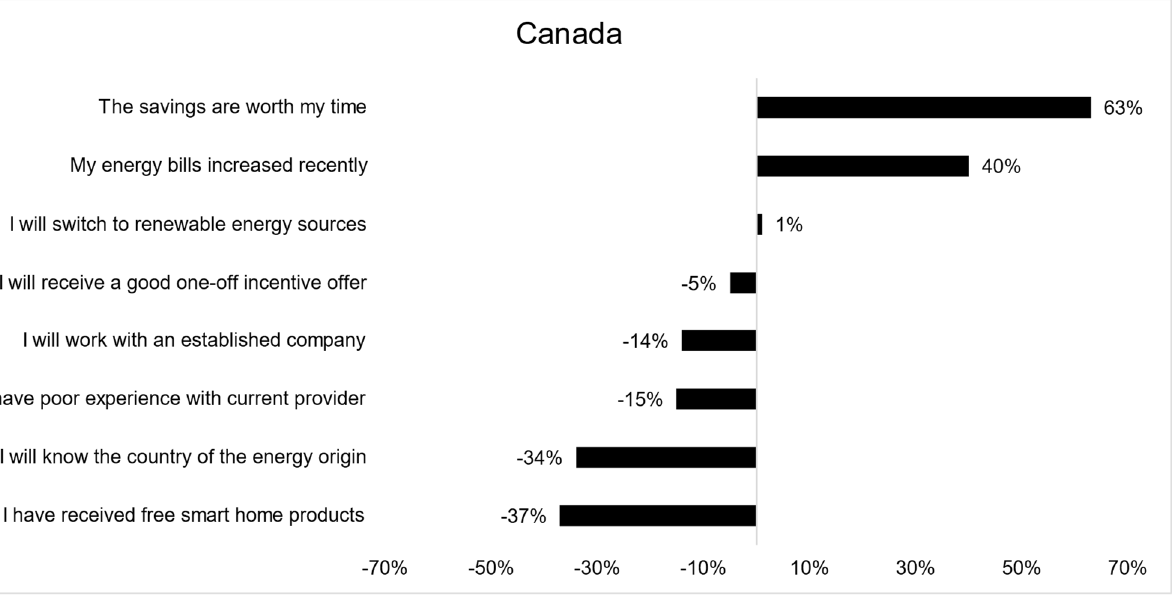
Figure 5. Utility attributes for various energy provider reasons in Canada . Source: own study.